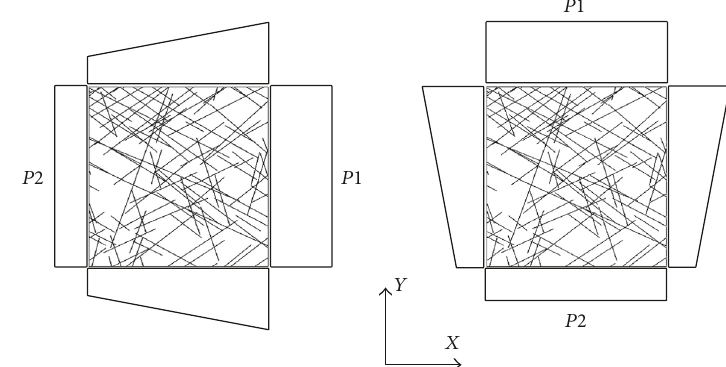
Figure 18: Hydraulic boundary conditions for calculation ( 𝑃1 and 𝑃2 represent different hydraulic